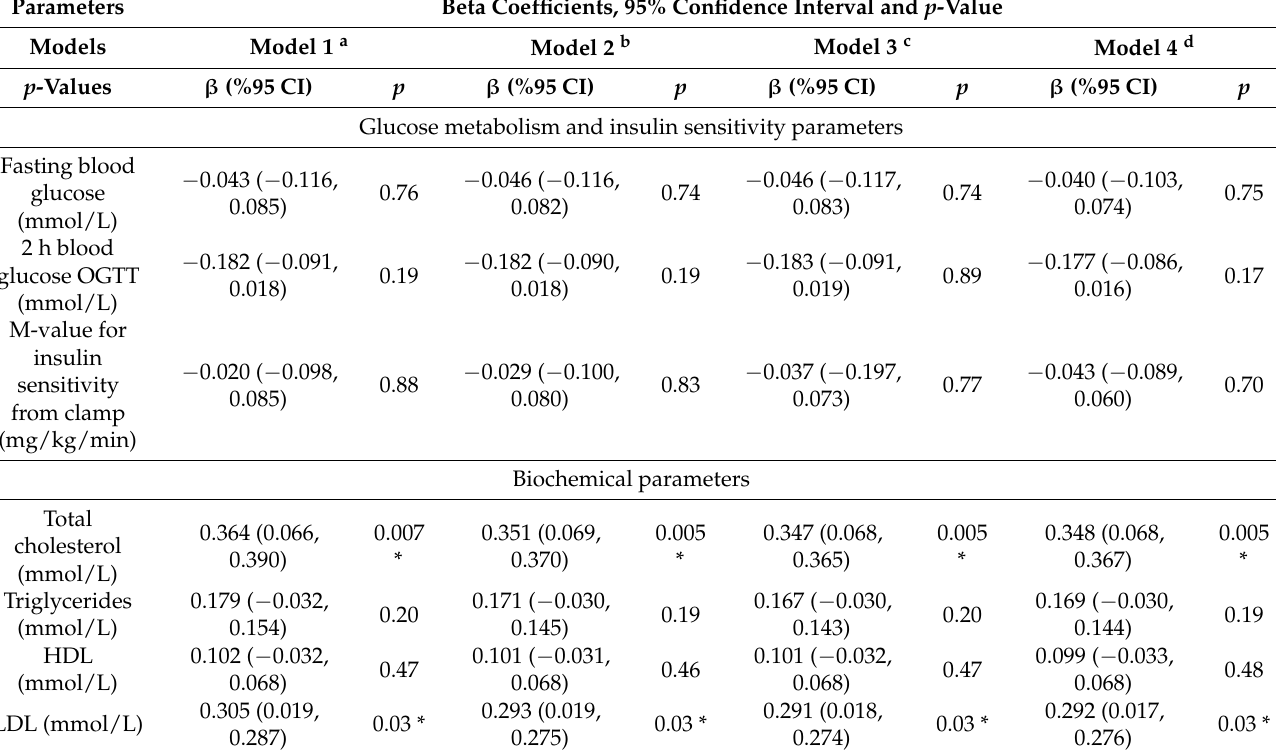
Table 3. Associations between Energy Adjusted Dietary Inflammatory Index and anthropometry data, insulin resistance and biochemical parameters ( n =